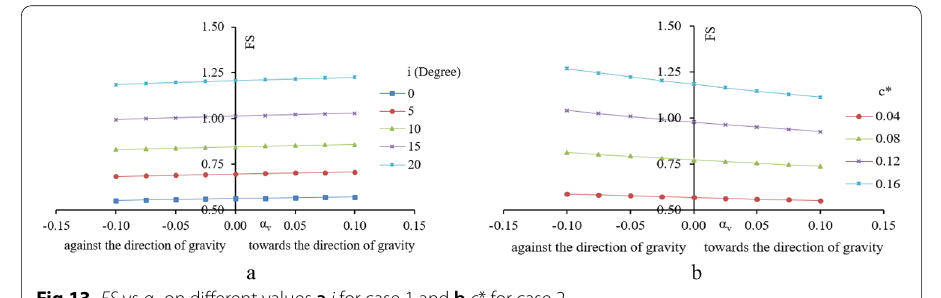
Fig.13 FS vs α v on different values a i for case 1 and b c * for case